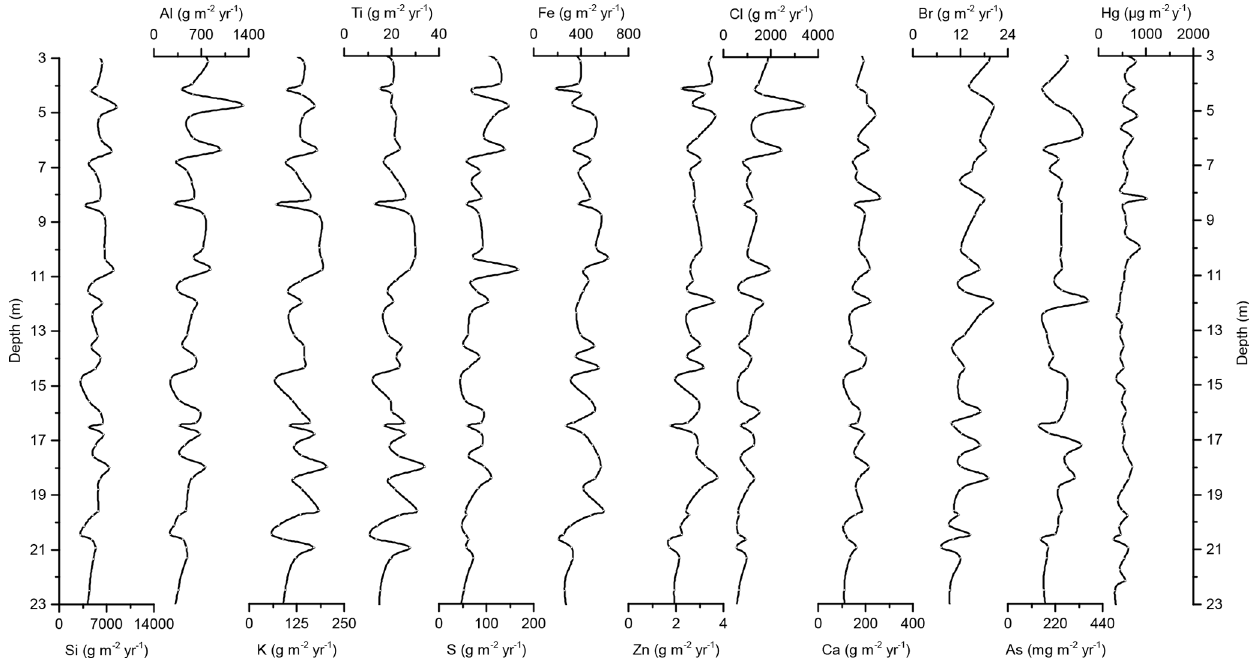
Figure 5. Down-core records of Si, Al, K, Ti, S, Fe, Zn, Cl, Ca, Br, As, and Hg accumulation rates of Adélie Basin sediments for the top 23m of the